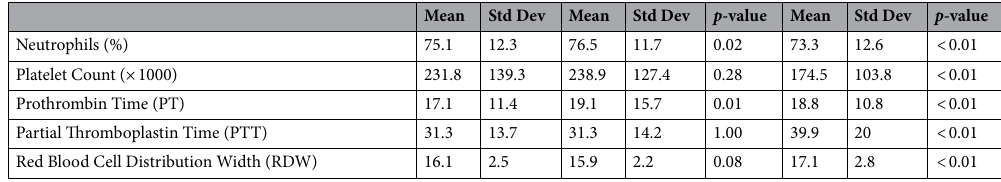
Table 1. Demographics and baseline data for the training and validation